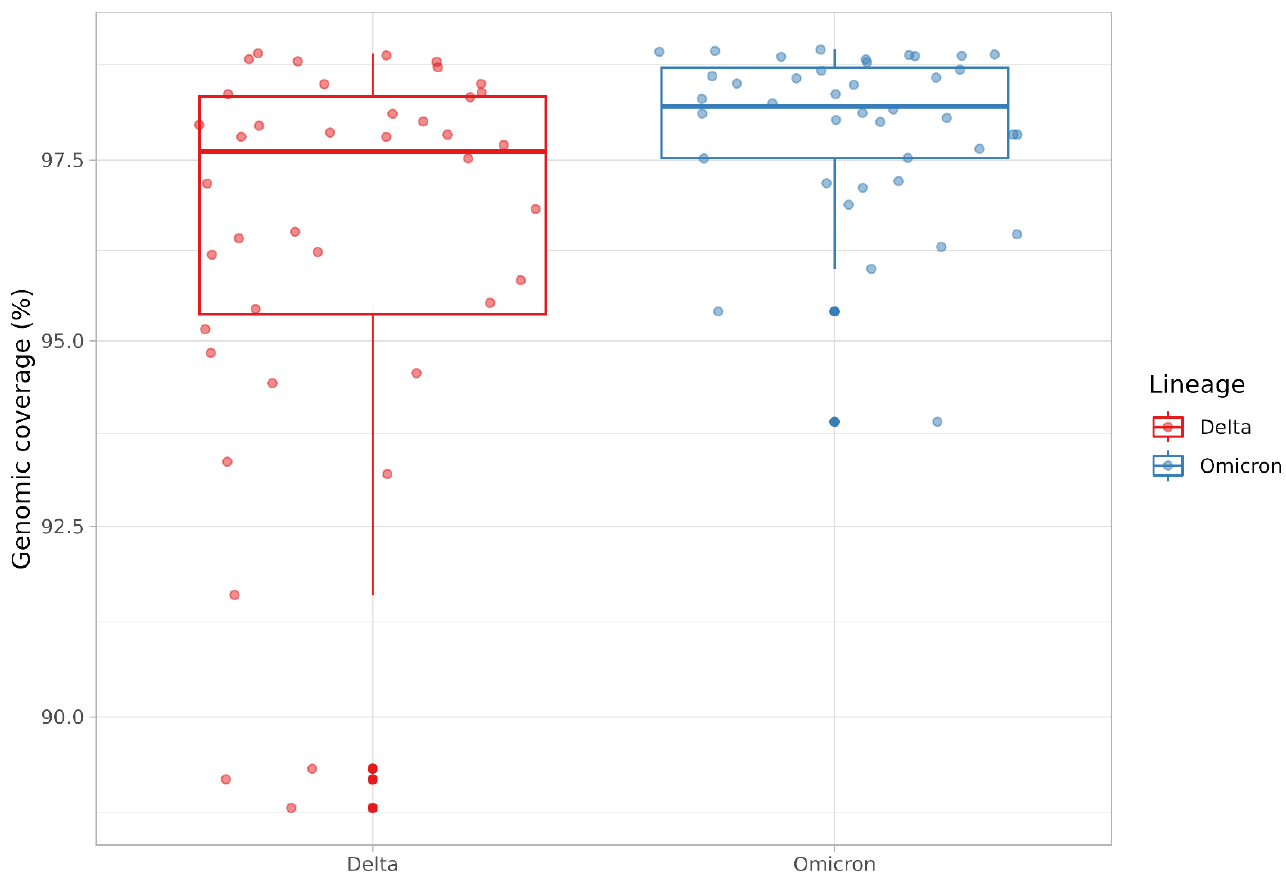
genome. The y -axis shows median coverage (among 40 samples) by genomic position. The blue line represents a median coverage value of 5.